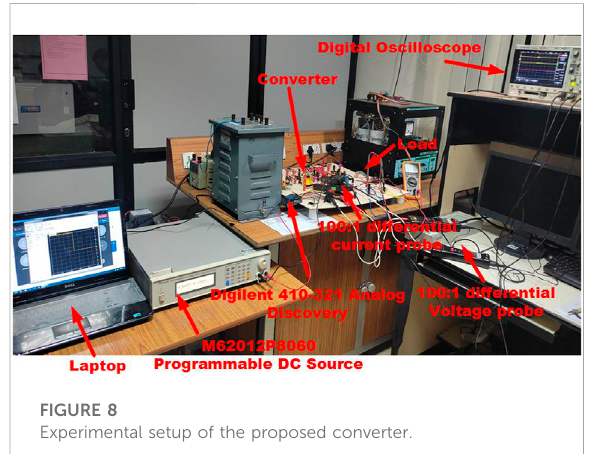
FIGURE 8 Experimental setup of the proposed converter.